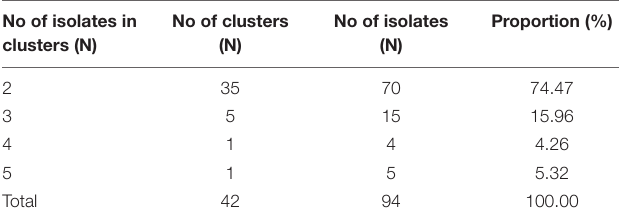
TABLE 1 | The cluster size and the number of genomic clusters of 94 Mycobacterium tuberculosis isolates. No of isolates in No of clusters clusters (N)